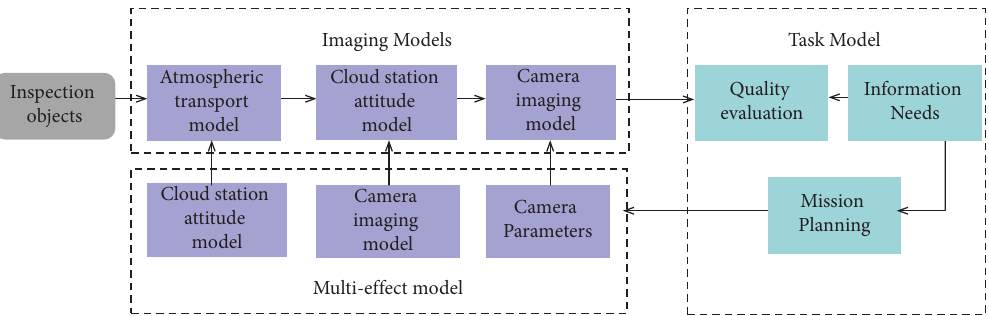
Figure 6: UAV inspection imaging link model.